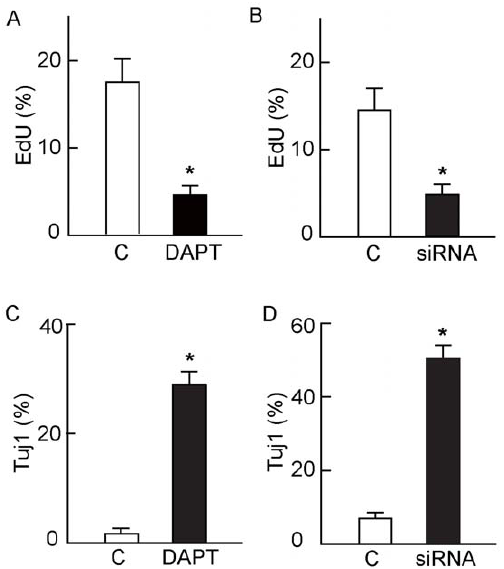
Figure 6. Effects of DAPT and RBPj k siRNA-mediated Notch inhibition on human neurosphere cell proliferation and neuronal differentiation. A and C: Cells dissociated from human neurospheres were allowed to adhere to Permanox tissue culture slides and cultured with and without 20 m M DAPT. After 96 h the cells were fixed and stained for Tuj1, and nuclei counterstained with DAPI. Fluorescent cells were counted in 5 random optical fields in each chamber. Error bars are 6 SEM, (values from 3–5 experiments). A: Significantly fewer DAPT-treated cells incorporated EdU than controls (* p , 0.001 ANOVA) while expression of Tuj1 (C) was markedly increased over control levels (* p , 0.001 ANOVA). B and D: The effect of siRNA knockdown on the human neurosphere cells prepared and cultured under the same conditions as in A and C. Relative to controls transfected with an irrelevant siRNA, after 96 h siRNA transfection with HsRBPJ_3 siRNA specific for RBPj k had (B) a lower rate of proliferation (* p , 0.001, ANOVA) and (D) increased expression of Tuj1 (* p , 0.001, ANOVA). Error bars are 6 SEM (n=3).